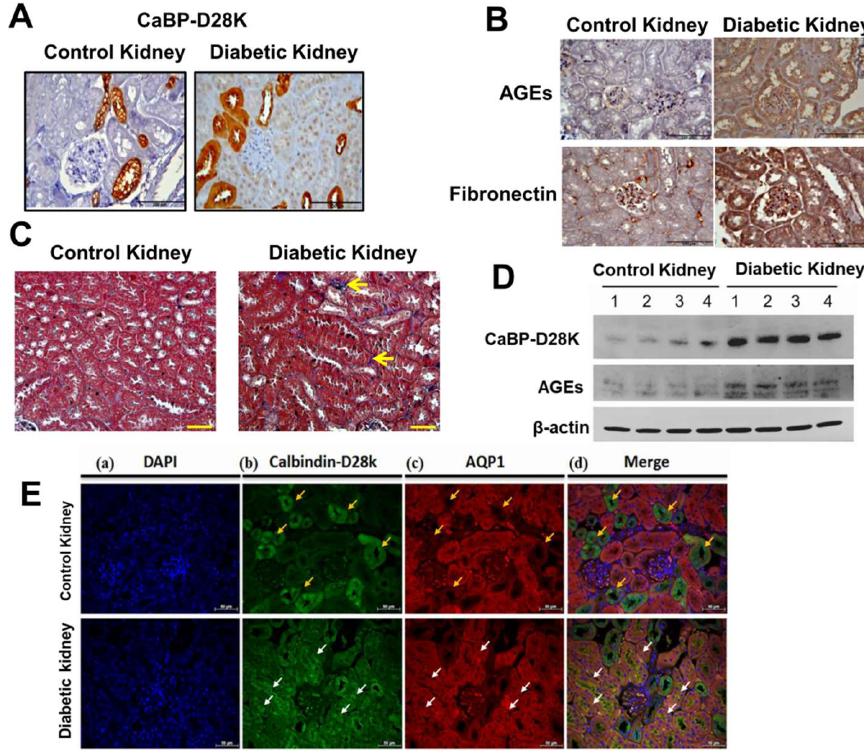
Figure 1. Expressions of calbindin-D28k and AGEs in the kidneys of db/db diabetic mice. The immunohistochemical stainings for calbindin-D28k ( A ) and AGEs and fibronectin ( B ) were performed in the sections of kidneys from control db/m+ mice or db/db diabetic mice. ( C ) Masson’s Trichrome staining detected the renal fibrosis in the kidneys of control and diabetic mice. Scale bar: 100 μm. ( D ) Western blotting analyzed the protein expressions of calbindin-D28k and AGEs in the kidneys of control and diabetic mice. ( E ) Expression of calbindin-D28k in the renal proximal tubules of db/db diabetic mice. The immunofluorescence double stainings for identifying nuclei (DAPI, blue; a), calbindin-D28k (green; b), and AQP-1 (proximal tubule marker) (red; c) were performed in the sections of kidneys from control db/m+ mice or db/db diabetic mice. The merge of staining was shown in d. The yellow arrows indicated for the calbindin D28k positive/AQP-1 negative regions. The white arrows indicated for the calbindin D28k positive/AQP-1 positive regions. Scale bar: 100 μm.